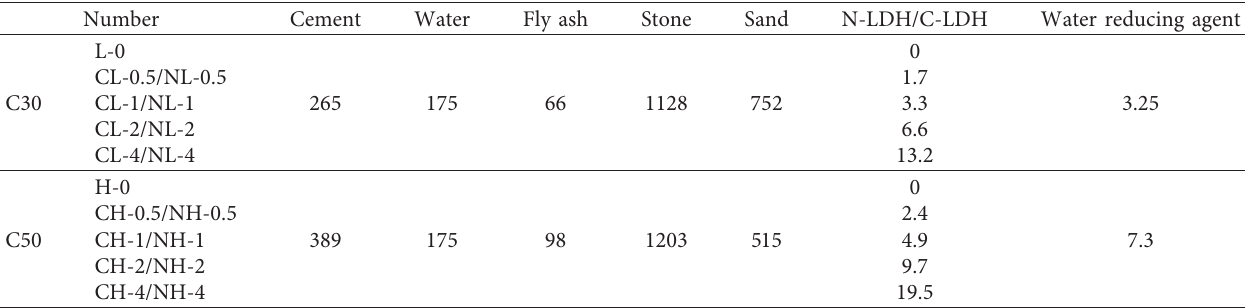
Table 5: Concrete mix ratio (kg/m 3 ).